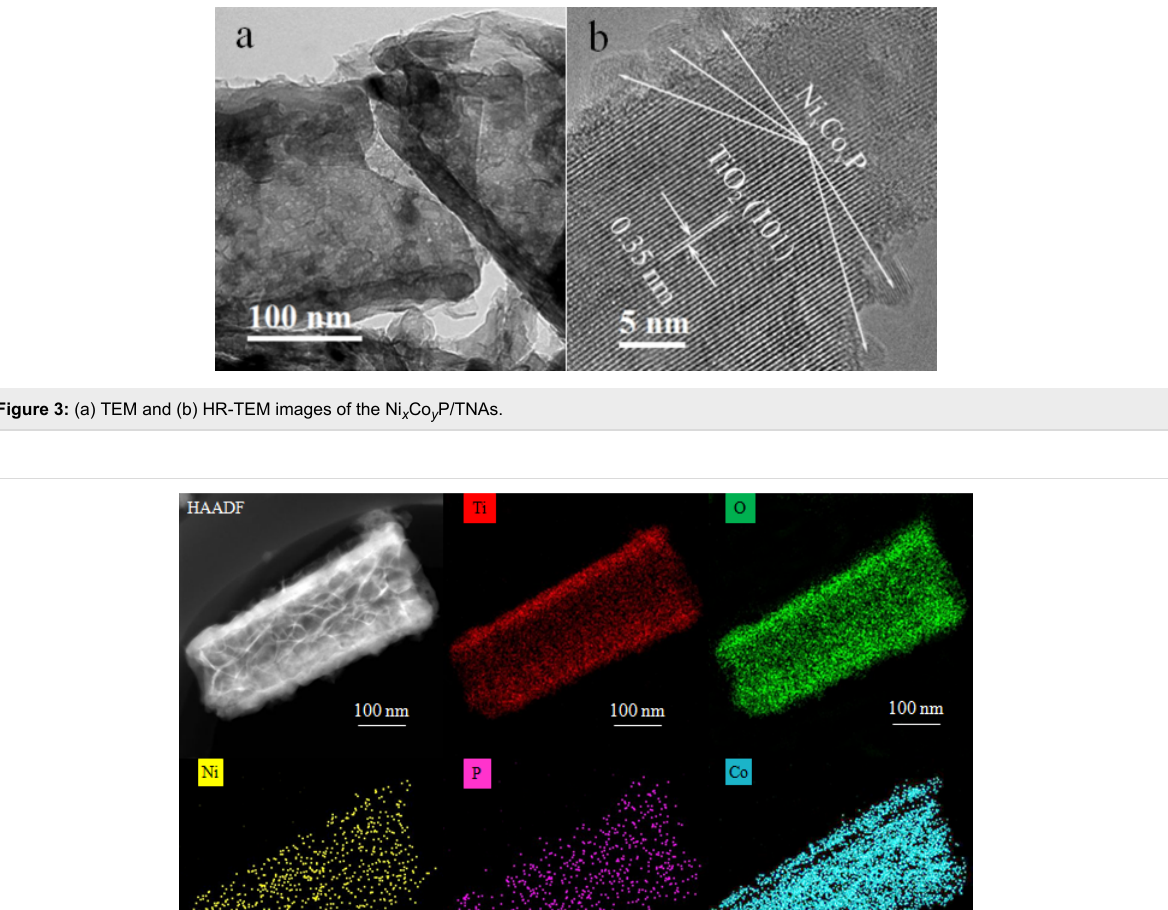
Ni − P bonds, positively shifted relative to that of metallic Ni (852.3 eV) (Figure 5c). The Ni 2p 3/2 peak at 861.5 and Ni 2p